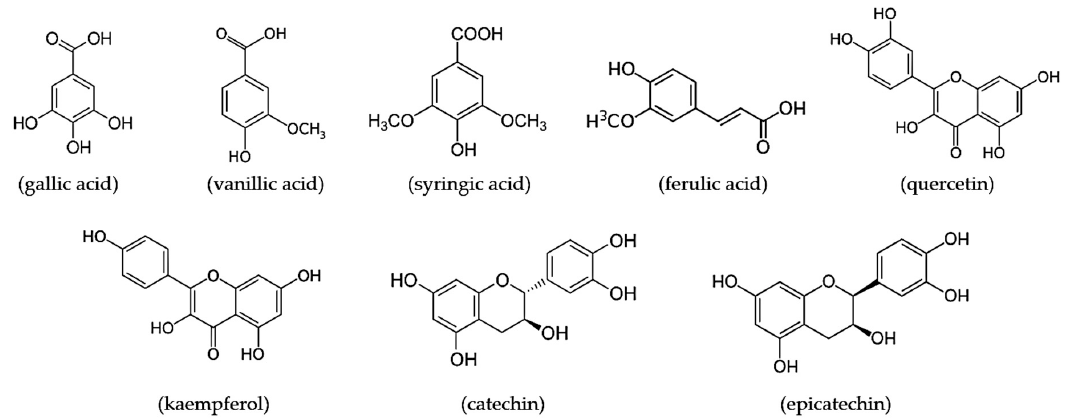
Figure 2. Chemical structures of the main phenolic compounds found in Quercus species.